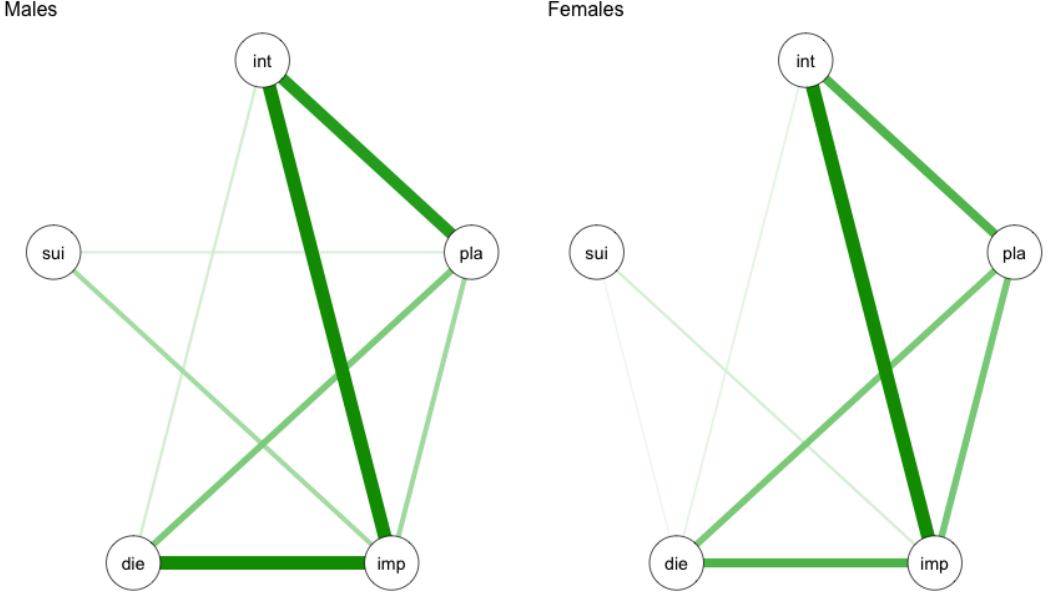
Figure 3. Hypothetical example of a network of suicidal symptoms for males and females. Int: intensity of suicidal thoughts; pla: concrete plans; imp: impulsivity; die: desire to die; sui: expectancy of suicidal behaviour. Green lines represent positive relationship. The thicker the line, the stronger the association.